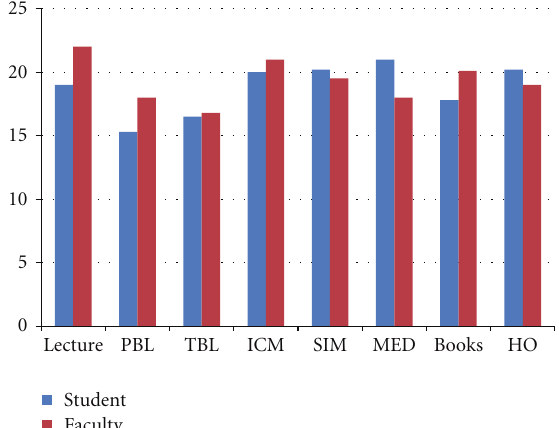
Figure 1: Comparison between faculty and students, average of the 5 questions for each modality. N = 13–29 faculty members and 260– 322 students. Di ff erences were significant for lectures ( P < . 001), mediasite ( P = . 001), textbooks ( P = . 002), and PBL ( P = .